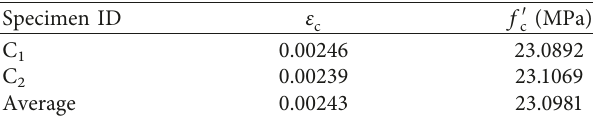
Table 4: Unconfined concrete specimens with steel